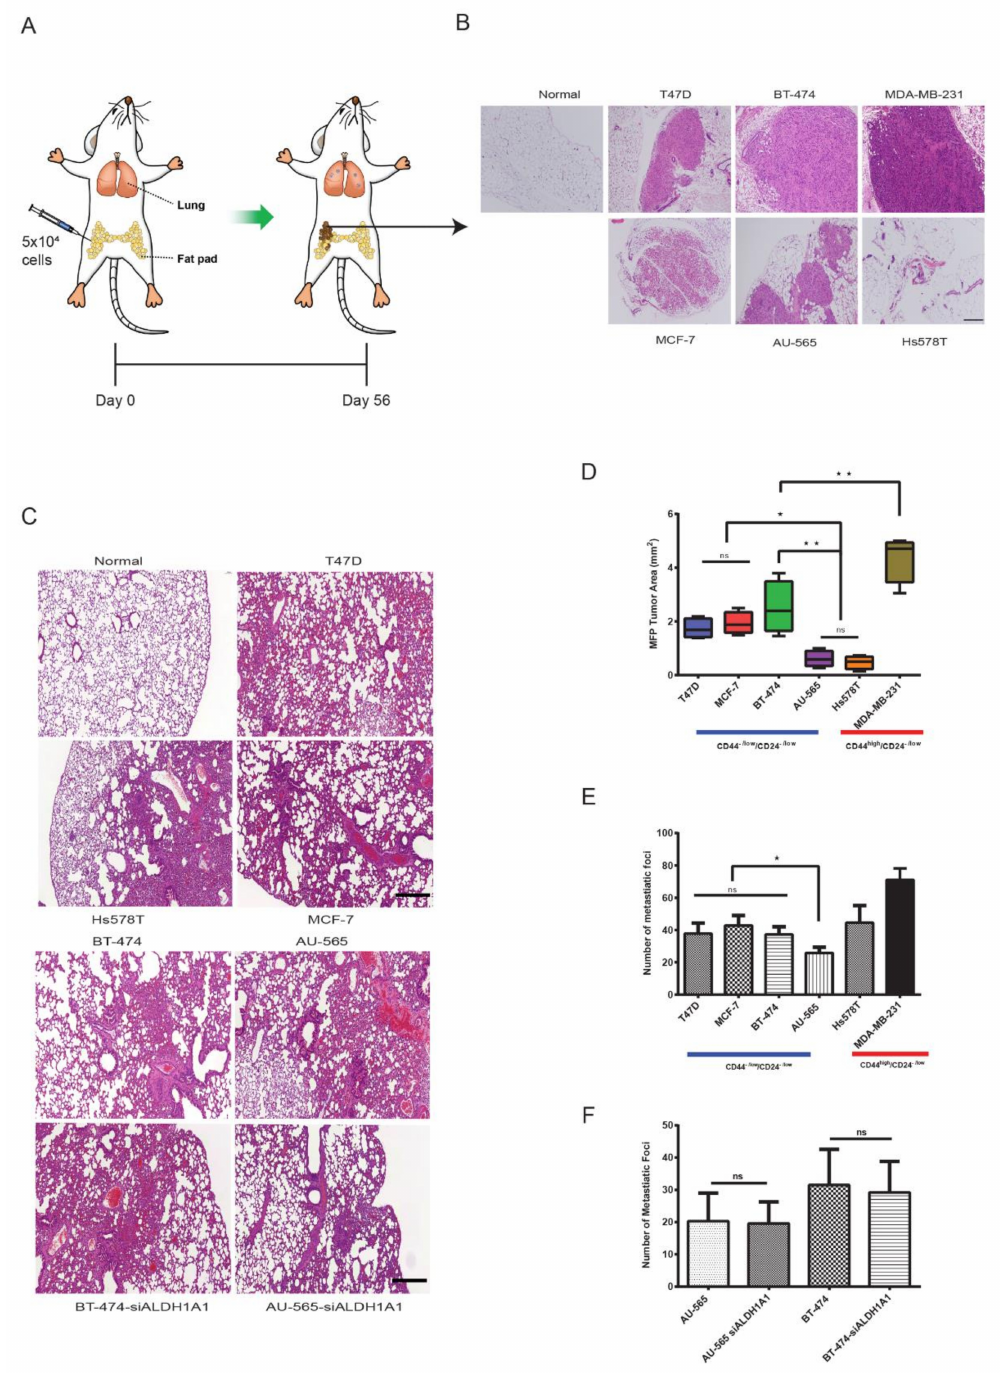
Figure 6. Luminal CD44 − / low / CD24 − / low cells cause metastasis in NSG mice. ( A ) Schematic representation of the xenotransplant experiment. Female NSG mice were injected with 5 × 10 4 cells from CD44 high / CD24 − / low , CD44 − / low / CD24 − / low and siALDH1 populations. The mammary fat pad(MFP)andlungswerecomparedfortumorigenicandmetastaticpotentialafter8weeksofincubation. ( B ) Representative images of H&E staining of the site of injection in the MFP. ( C ) Representative images of H&E staining of lung metastasis. ( D ) Analysis of tumor area in the MFP of NSG mice. ( E ) Analysis of lung tumor foci. ( F ) Comparison of lung tumor metastatic foci between non-si and siALDH1A1 in HER2-OE cell lines. Data represent the mean ± SD of three independent experiments; * p < 0.05 and ** p < 0.01. Scale bar = 200 µ